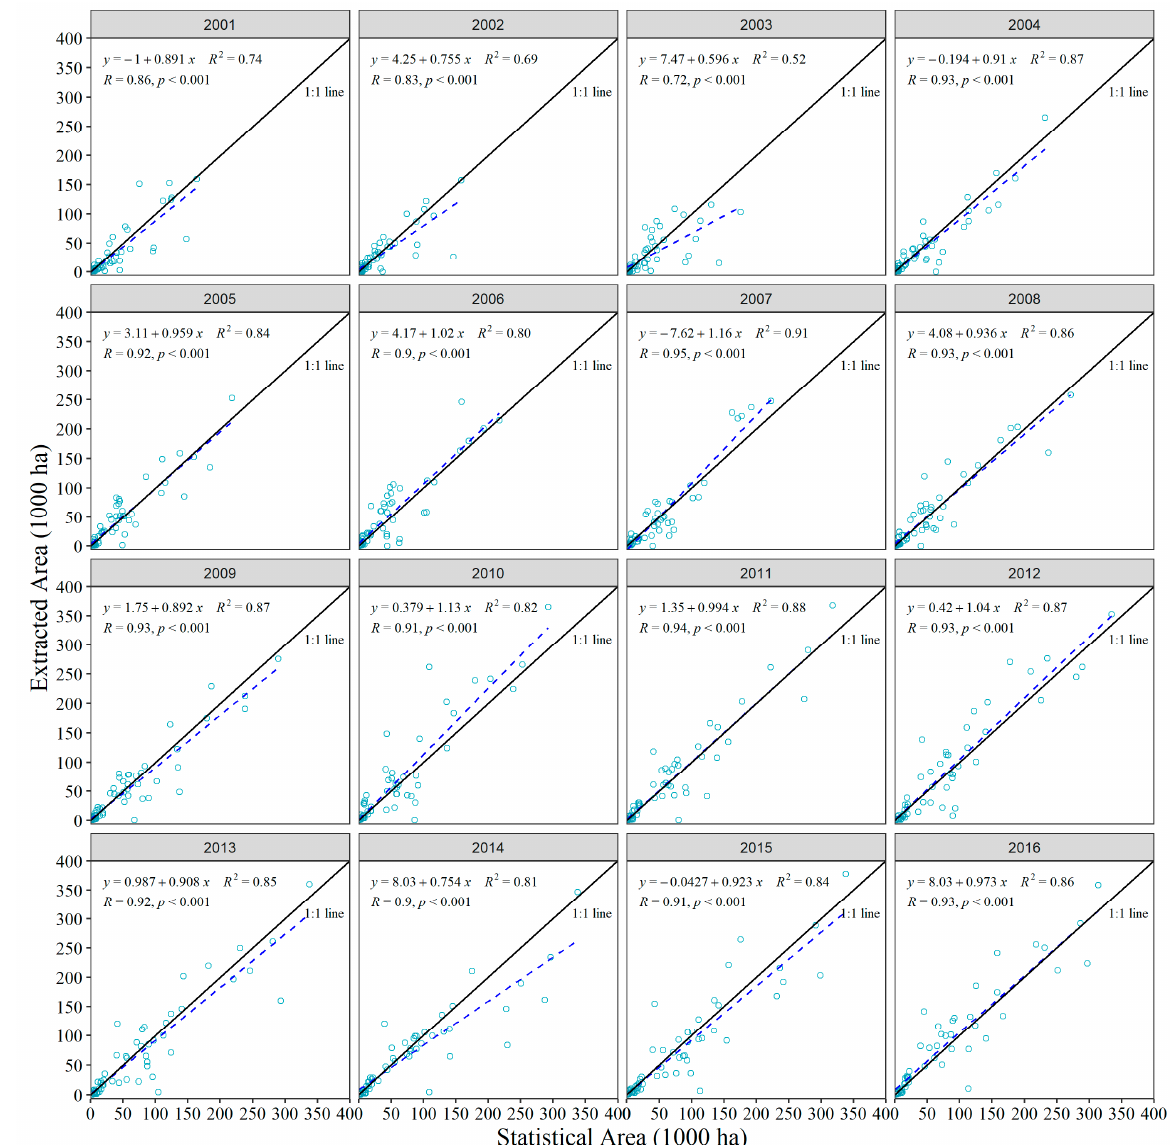
Figure 10. Results of planting area extraction for spring maize.